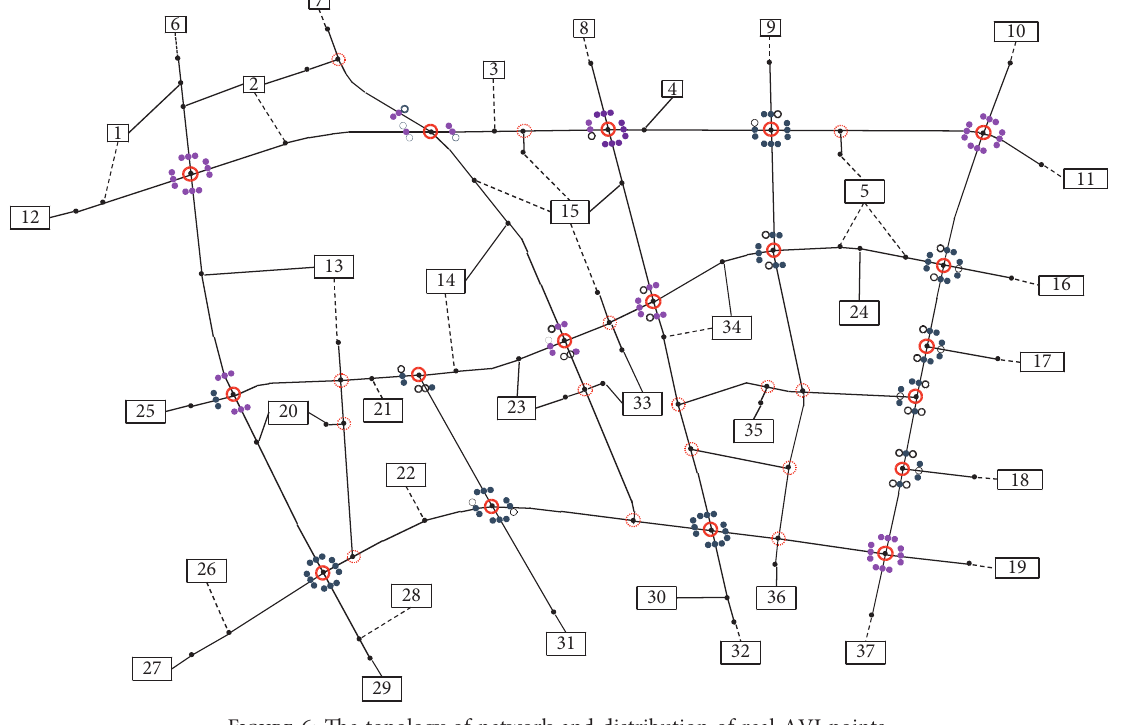
Figure 6: The topology of network and distribution of real AVI